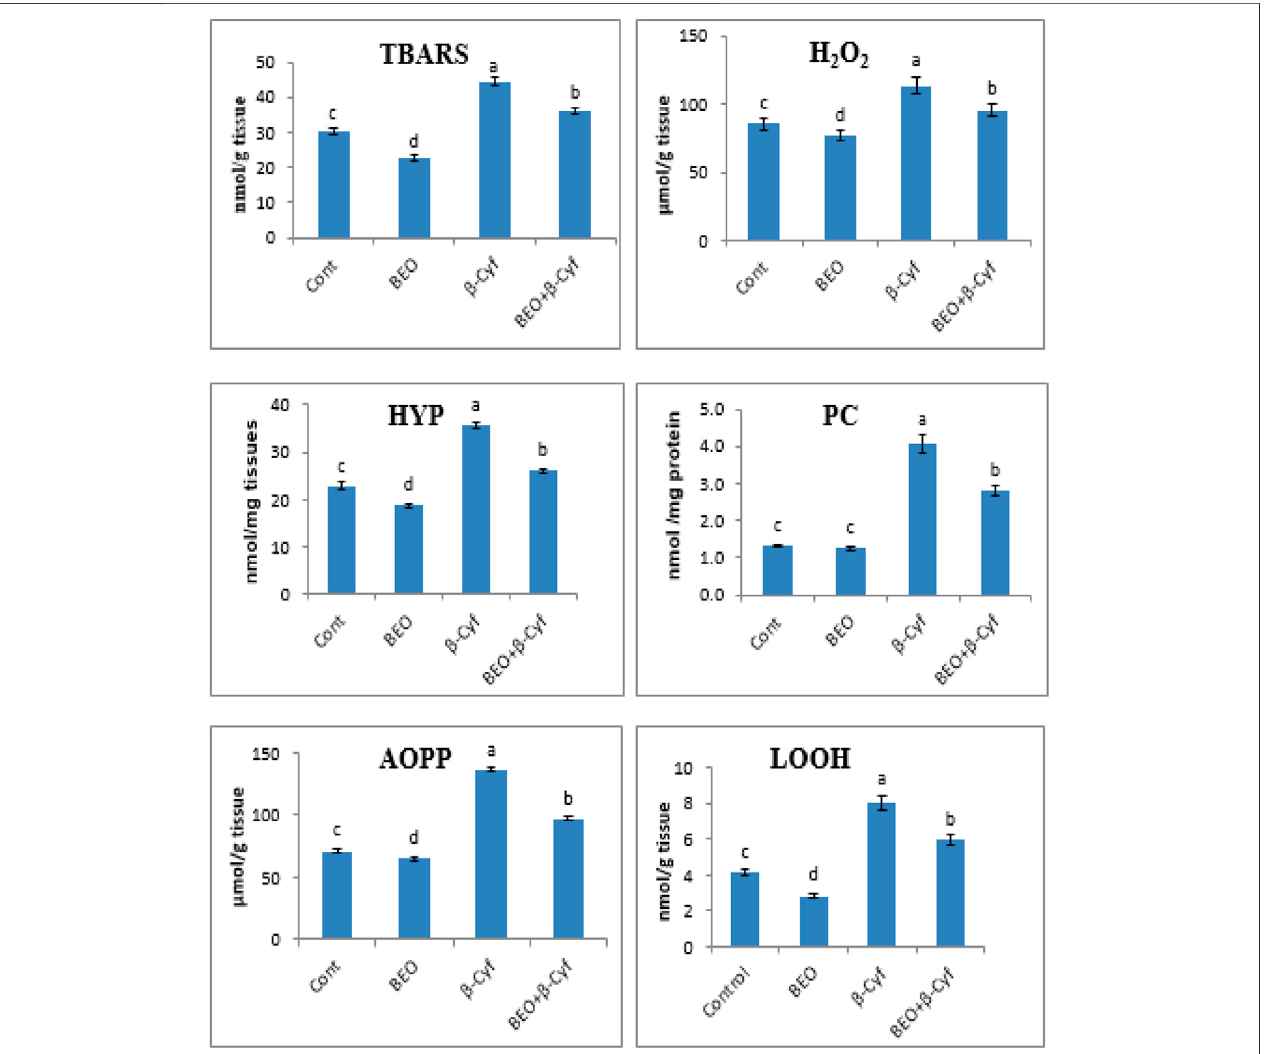
FIGURE 2 | Lipid peroxidation and protein oxidation in the liver of male rats given BEO, β -Cyf, and BEO plus β – Cyf. Values are expressed as mean ± SE of seven rats per group. Columns with different letters are signi fi cantly different at p < 0.05. Groups are compared as follows: BEO and β – Cyf are compared to negative control while BEO + β -Cyf group are compared to the positive control group, β -Cyf. Abbreviations: TBARS, thiobarbituric acid reactive substances, H 2 O 2 ; hydrogen peroxide, HYP; hepatic hydroxyproline, LOOH; lipid hydroperoxide, PC; protein carbonyl, AOPP; advanced oxidized protein product.